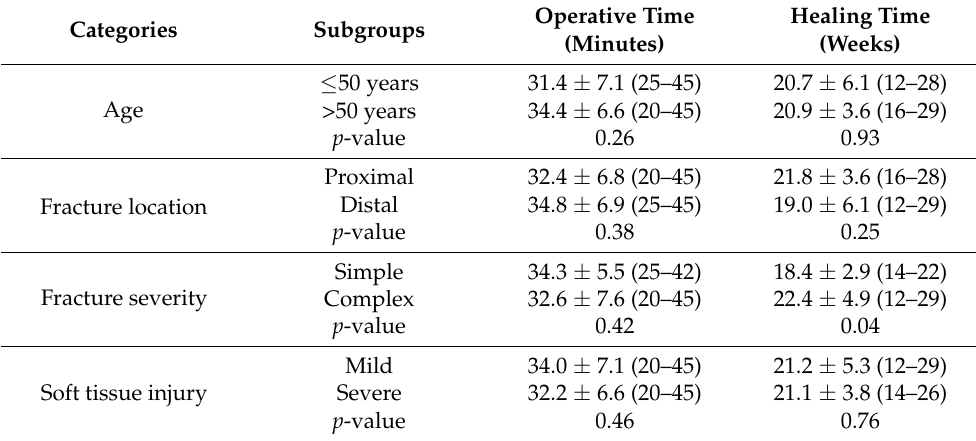
Table 2. Clinical outcomes in the subgroups of patients according to the categories age, fracture location, fracture complexity, and soft tissue injury, presented in terms of mean value, standard deviation and range, together with the p -values from the corresponding subgroups